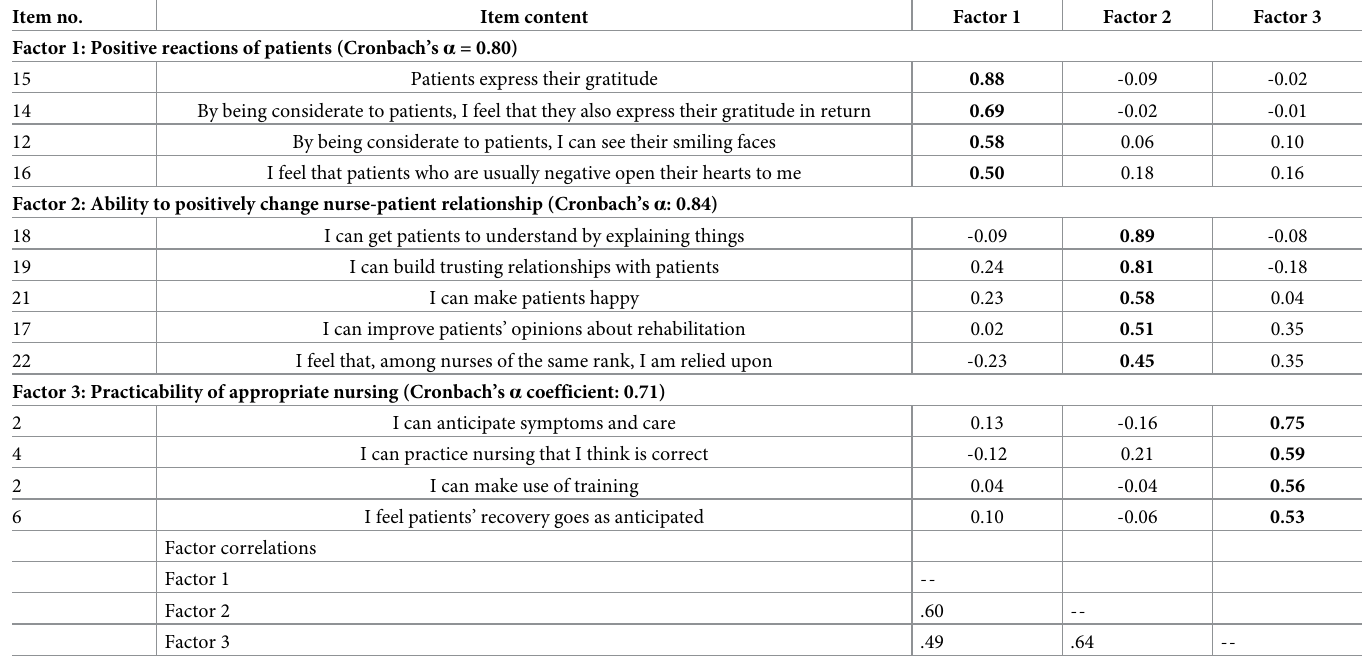
Table 2. Factors related to improved self-efficacy among psychiatric nurses (n = 132). Item no.